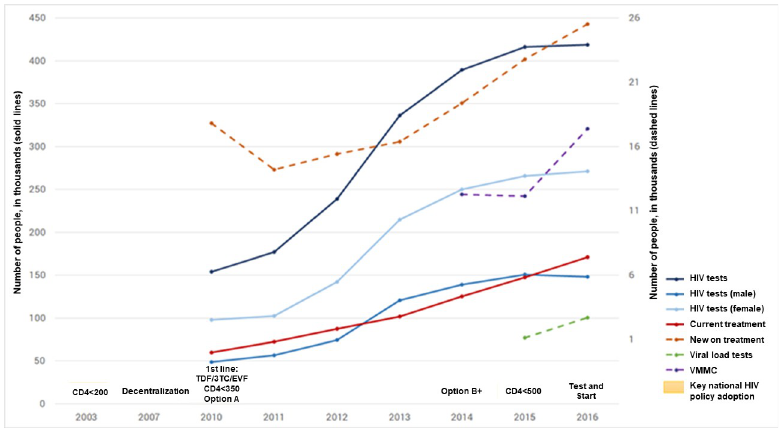
Fig 2. Key national HIV policy and program achievements, Eswatini, 2003–2016 [13]. Black solid line: HIV tests; blue solid line: HIV tests (Male); light blue solid line: HIV tests (Female); red solid line: currently on treatment; orange dotted line: new on treatment; green dotted line: viral load tests; purple dotted line: VMMC; text boxes: key national HIV policy adoption.